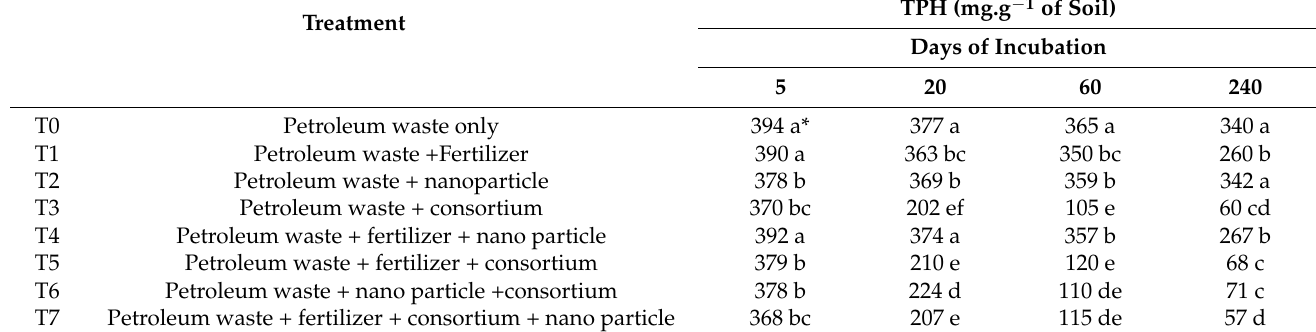
Table 1. The difference in the degradation of total petroleum hydrocarbons in petroleum waste (T0) and other treated soils (T1–T7) at 5, 20, 60, and 240 days of incubation. TPH (mg.g − 1 of